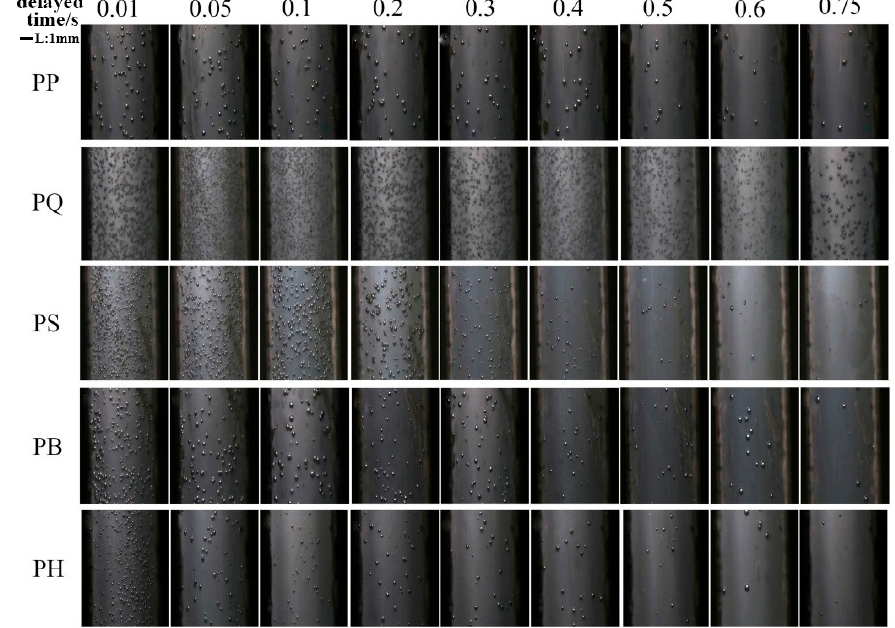
Figure 14. Pictures of the bubbles of the PP composite with different mold opening times.